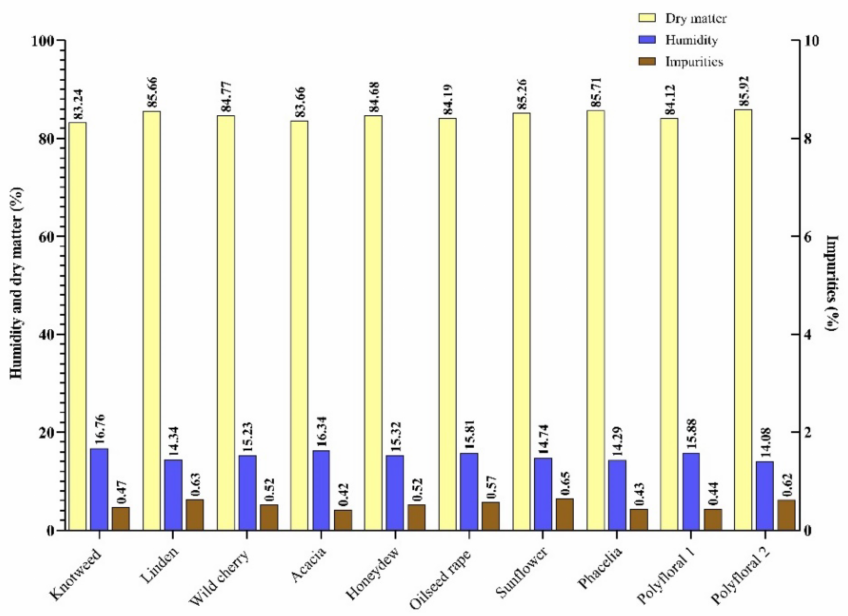
Figure 1. Humidity (H), dry matter (D.M.) and impurities (I) content (%) of the honey